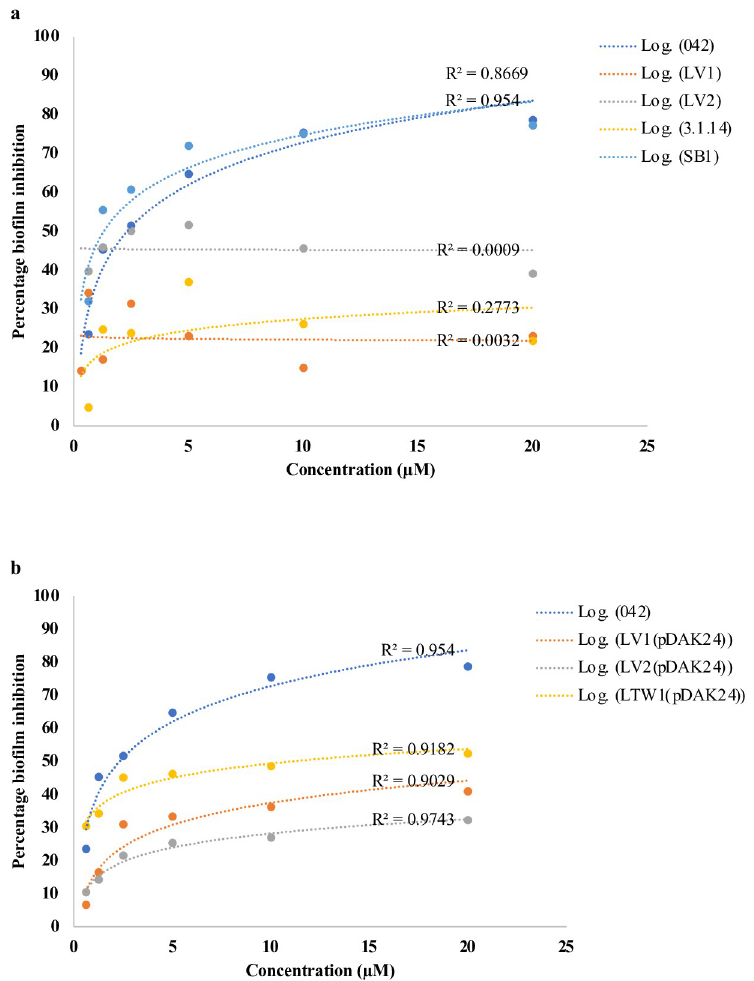
Fig 8. (a-b) Concentration dependent biofilm inhibition in E . coli 042, aap mutants and aap complimented strains by MMV687800. (a) Biofilm inhibition in aap mutants were not concentration dependent compared to wild type strain 042 and non- aap mutant SB1 (b) Inhibition of biofilms in aap complimented strains was concentration dependent and similar to those of wild type strain 042. 042 is the prototypical EAEC strain from Peru, LV1: 042 Δ aap , LV2; 042 Δ aap Δ hra1 and LTW1: 042 Δ aap Δ aafA . LV1(pDAK24), LV2(pDAK24), and LTW1(pDAK24) are complement strains of LV1, LV2 and LTW1 mutants with aap